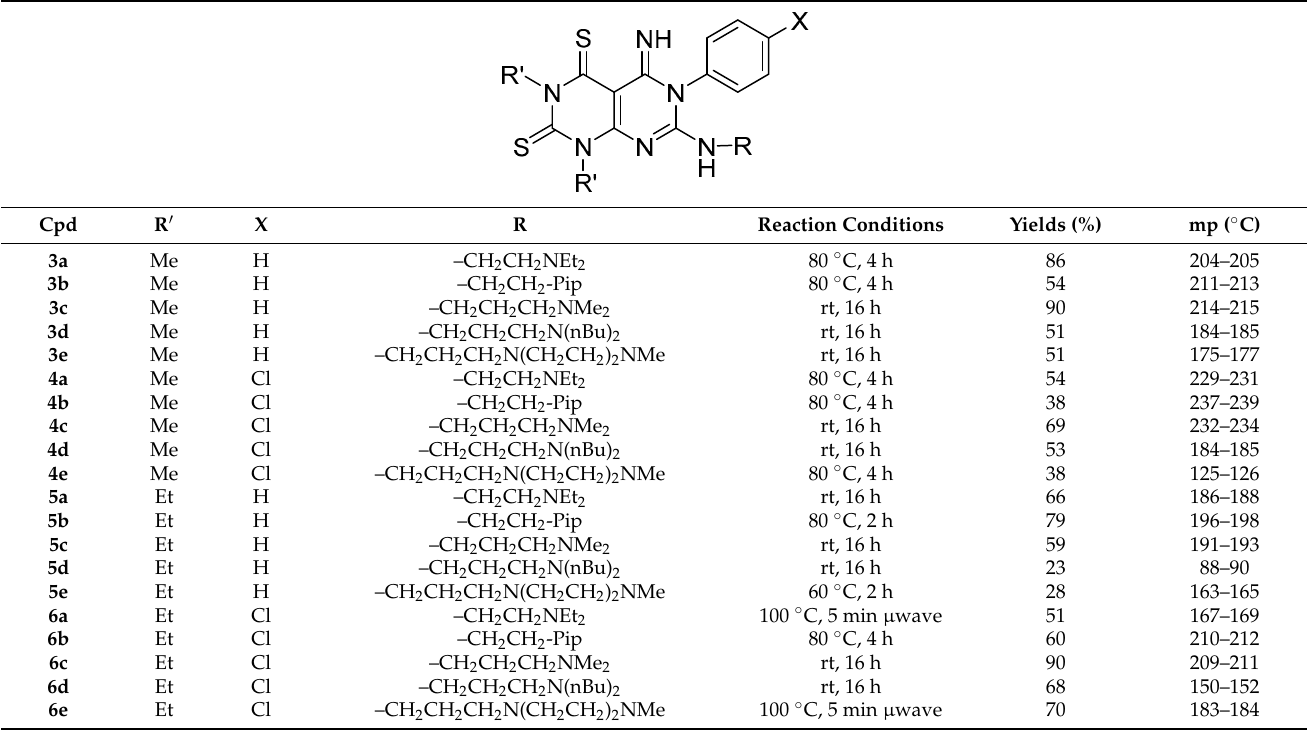
Table 1. Reaction conditions, yields and melting points of compounds 3–6.